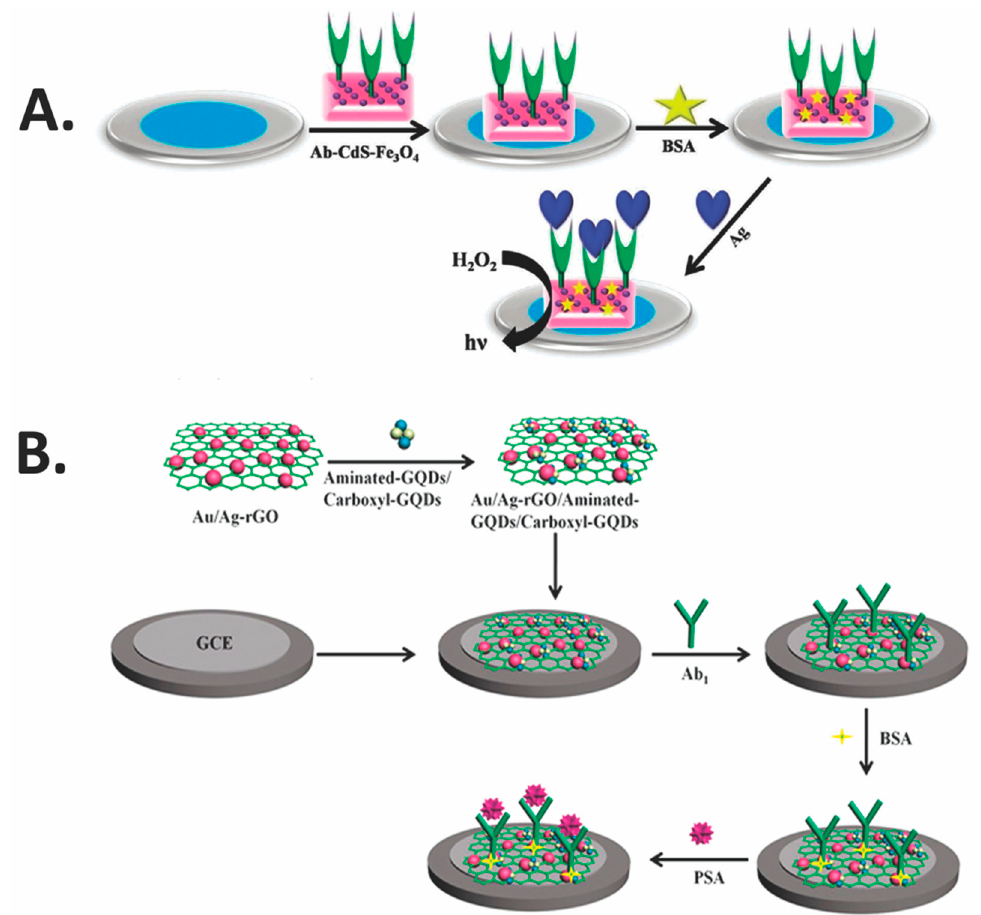
Figure 9. Quantum dots nanocomposite based ECL nanobiosensors: ( A ) ECL nanobiosensor with nanocomposite of CdS-Fe 3 O 4 . Reprinted from Ref. [80] with permission from the Royal Society of Chemistry; ( B ) ECL nanobiosensor with nanocomposite of Au/AgrGO. Reprinted from Ref. [38] with permission from Nature.